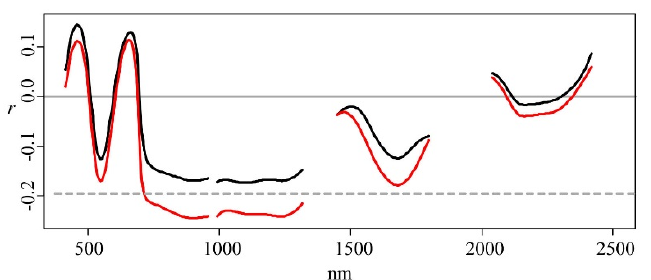
Figure 3. Pearson’s correlation coefficients ( r ) between single wavebands and the species richness ln(SR) (red), and the inverse Simpson’s diversity index iSDI (black) for the whole data set ( n = 102). Correlations below the dotted line are significant ( p < 0.05).